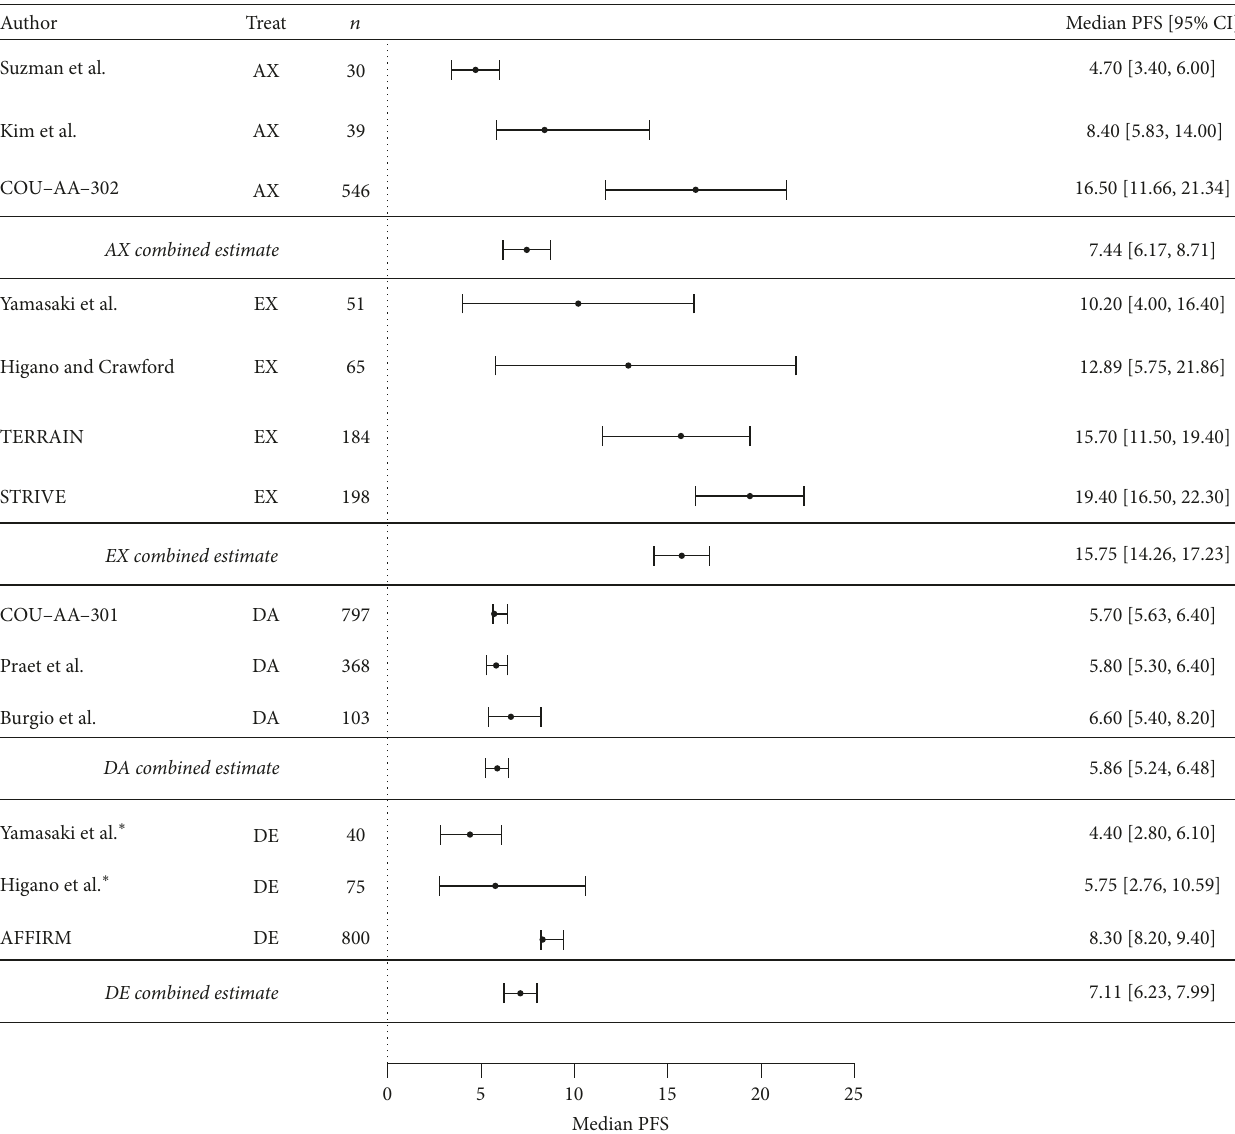
Figure 3: Forest plot depicting median radiographic PFS (in months) for AX ( 𝑛 = 3 ), EX ( 𝑛 = 4 ), DA ( 𝑛 = 3 ), and DE ( 𝑛 = 3 ) cohorts.